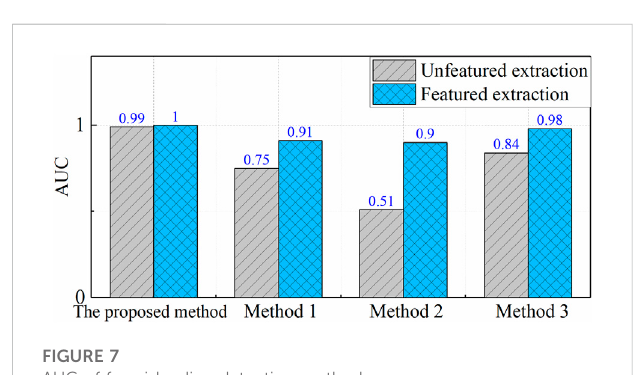
FIGURE 7 AUC of four islanding detection